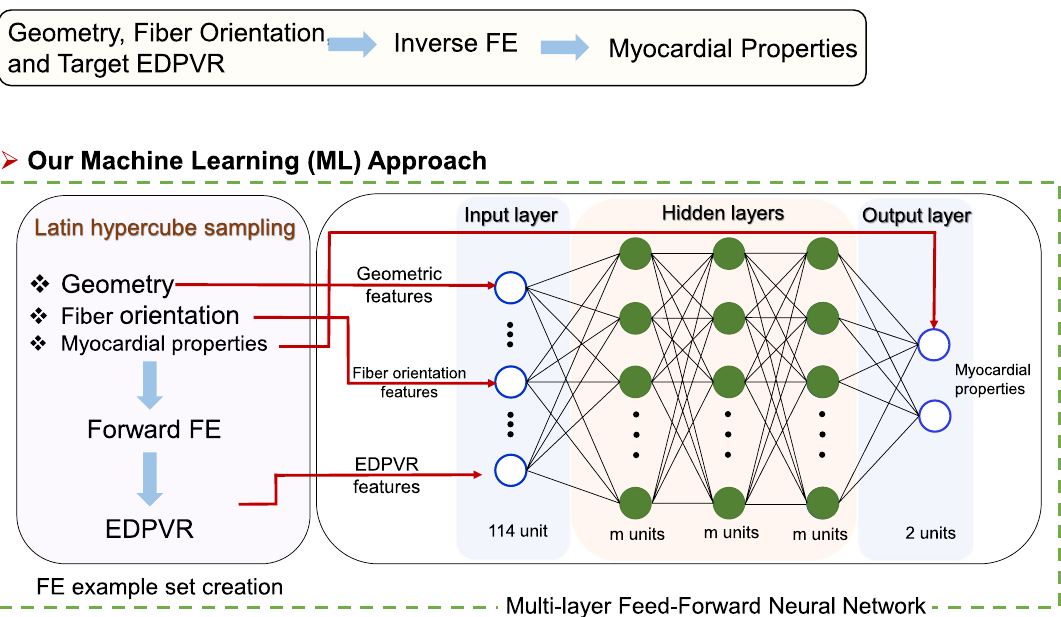
Figure 1. The flowchart for traditional inverse FE approach versus the proposed ML